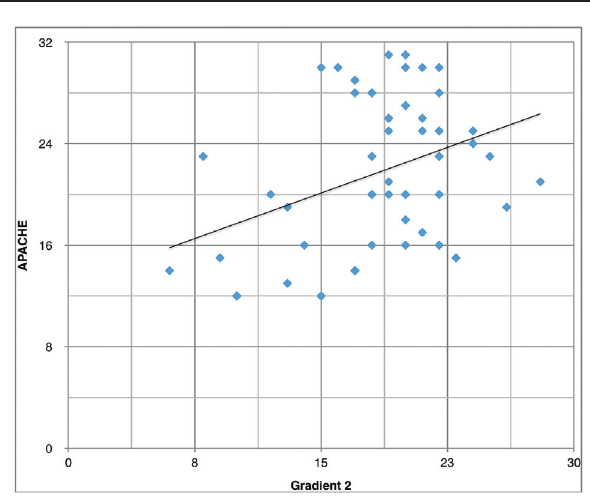
APACHE score and gradient correlation on day 2 of